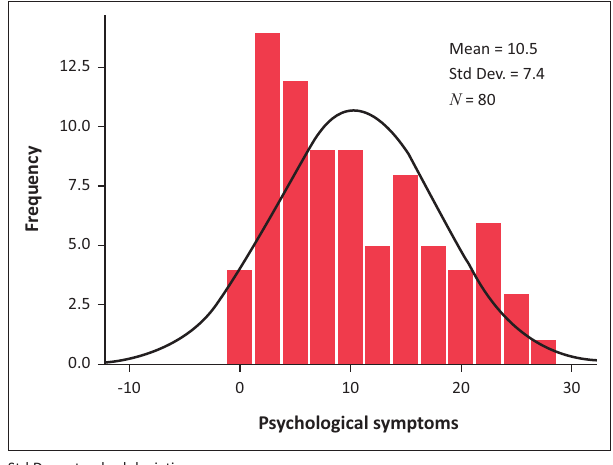
FIGURE 1: Psychological symptoms of